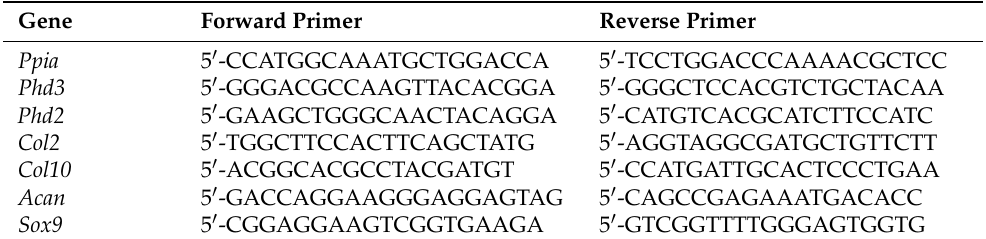
Table 1. Primer sequences used for real time